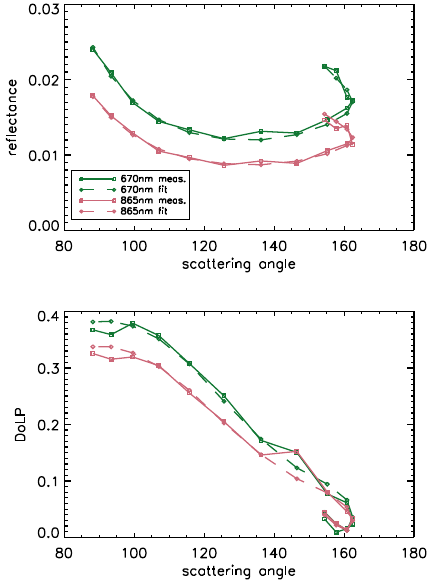
Figure 1. A POLDER-3/PARASOL observation of a scene with ∼ 20% cover. The 670 and 865nm bands are shown in, respectively, green and red. The dashed lines show the best fit to this observa- tion (assuming clear sky conditions). The fit has a high χ 2 value ( ∼ 13.7) mostly due to the discrepancy near the cloud-bow, which is visible in the degree of linear polarization at a scattering angle of ∼ 140 ◦ . The measurement errors are of the size of the